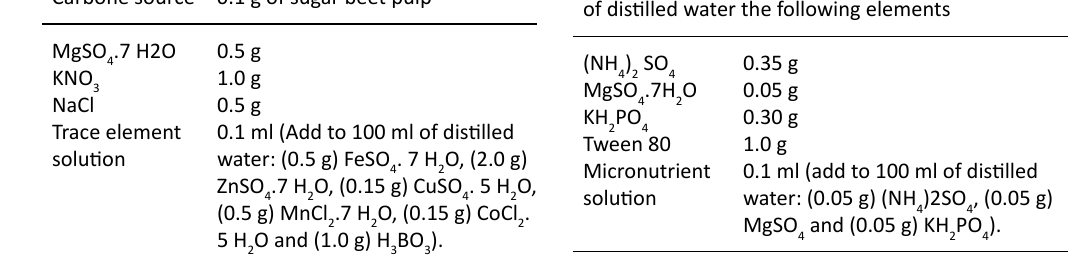
Table 2. Nutrient solution composition: Add to 100